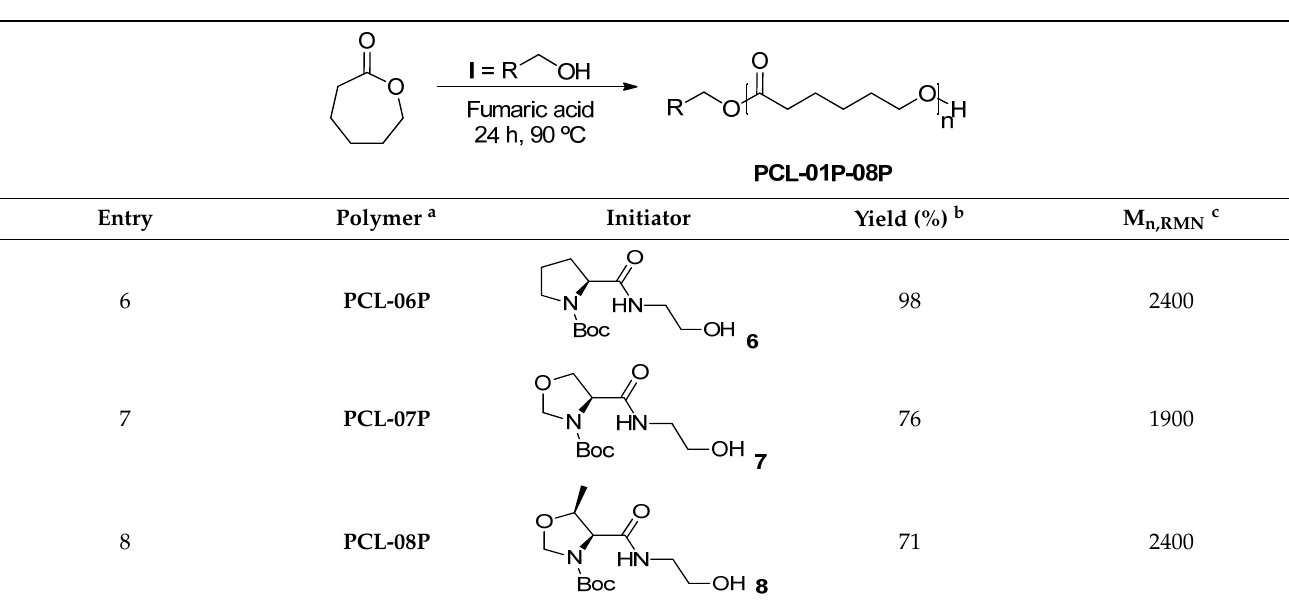
Table 2. Application of the optimized conditions for polymerization of ε -caprolactone initiated by Table 2. Cont. compounds 1 – 8